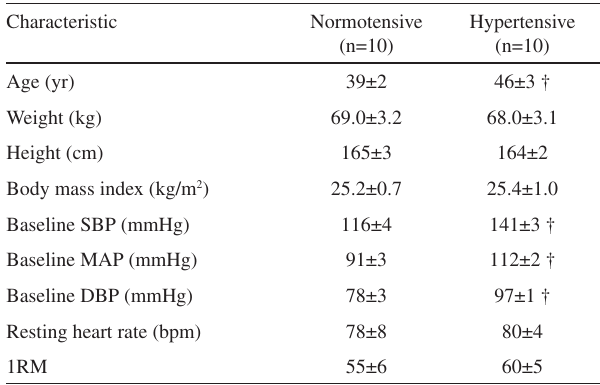
Table 1 - Physical and cardiovascular characteristics of nor- motensive and hypertensive